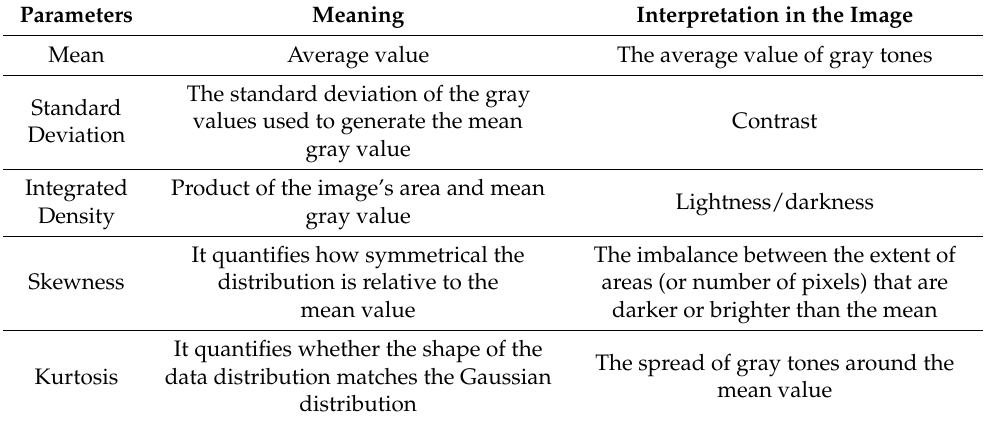
Contrast Lightness/darkness